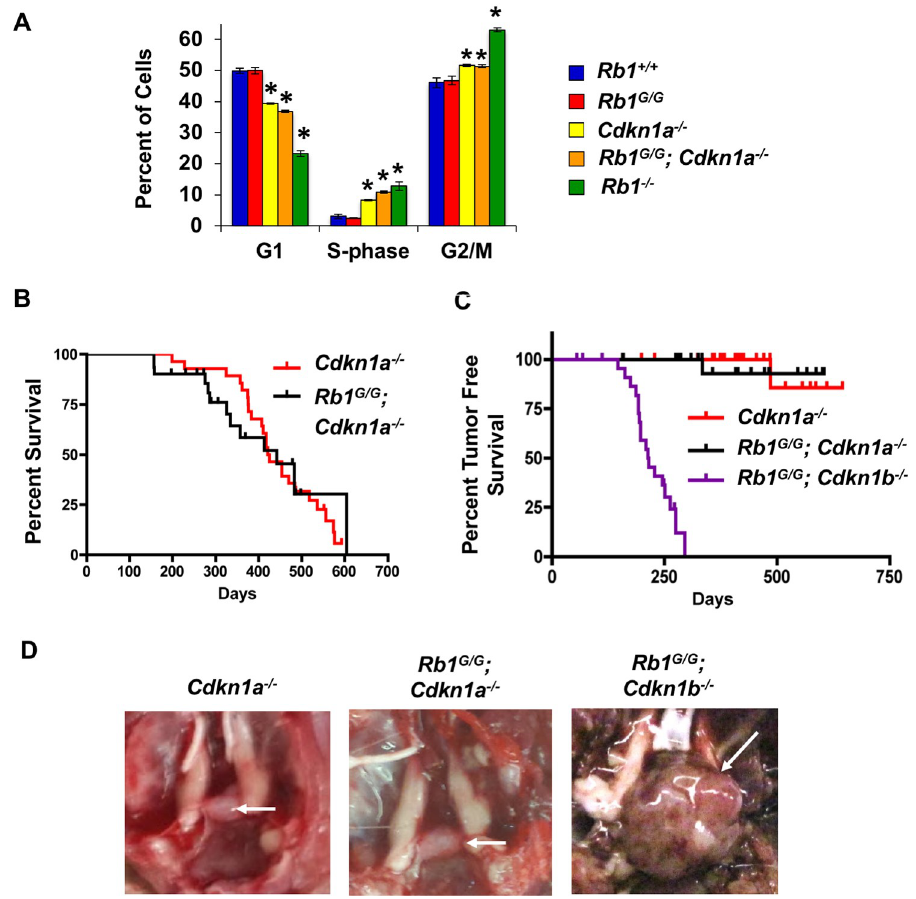
Fig 3. Combining the Rb1 G mutation with Cdkn1a deficiency does not create cancer susceptibility. (A) Propidium iodide and BrdU staining of MEFs following 15 Gy of ionizing radiation. S-phase was determined by BrdU incorporation and flow cytometry. An average of 3 replicates are shown, error bars indicate one standard deviation. An asterisk indicates a significant difference from wild type (p < 0.05 using a t-test). (B) Kaplan-Meier analysis of overall survival of the indicated genotypes of mice. Mice were monitored until protocol endpoints. The mean survival of Rb1 G/G ; Cdkn1a -/- (419 days, n = 25) and Cdkn1a -/- (442 days, n = 24) mice are not statically different from one another using the log-rank test (p = 0.9059). (C) Kaplan-Meier analysis of tumor-free survival of the indicated genotypes. Rb1 G/G ; Cdkn1a -/- and Cdkn1a -/- are not statically significant from one another using the log-rank test (p = 0.7919). Previously determined cancer free survival of Rb1 G/G ; Cdkn1b -/- mice is shown for comparison. (D) Whole mount images of pituitaries of aged Cdkn1a -/- and Rb1 G/G ; Cdkn1a -/- animals demonstrate normal anatomical structure. A pituitary tumor from an Rb1 G/G ; Cdkn1b -/- mouse is shown for comparison. Pituitary glands/tumors are indicated by white